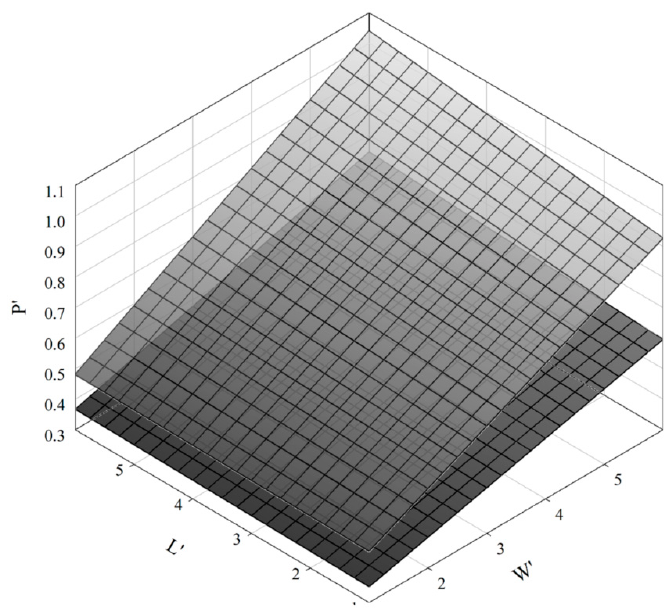
Figure 9. Parametric surface: inline (solid) and staggered (translucent).